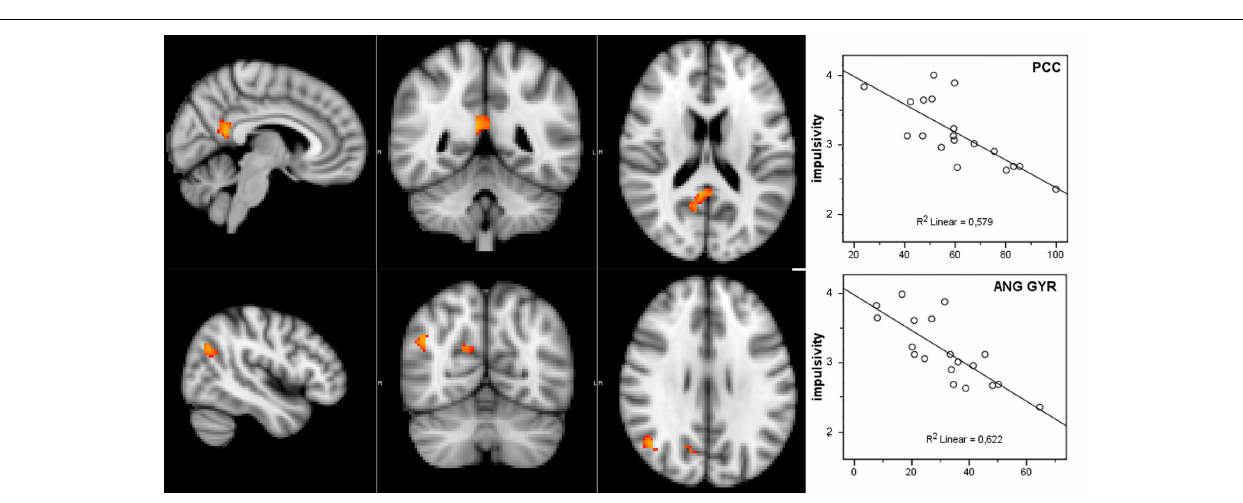
FIGURE 3 | Negative correlation between functional connectivity within the DMN and participant’s impulsivity scores: (left) correlation overlaid over anatomical template, (right) scatter plot of functional connectivity PE values and impulsivity